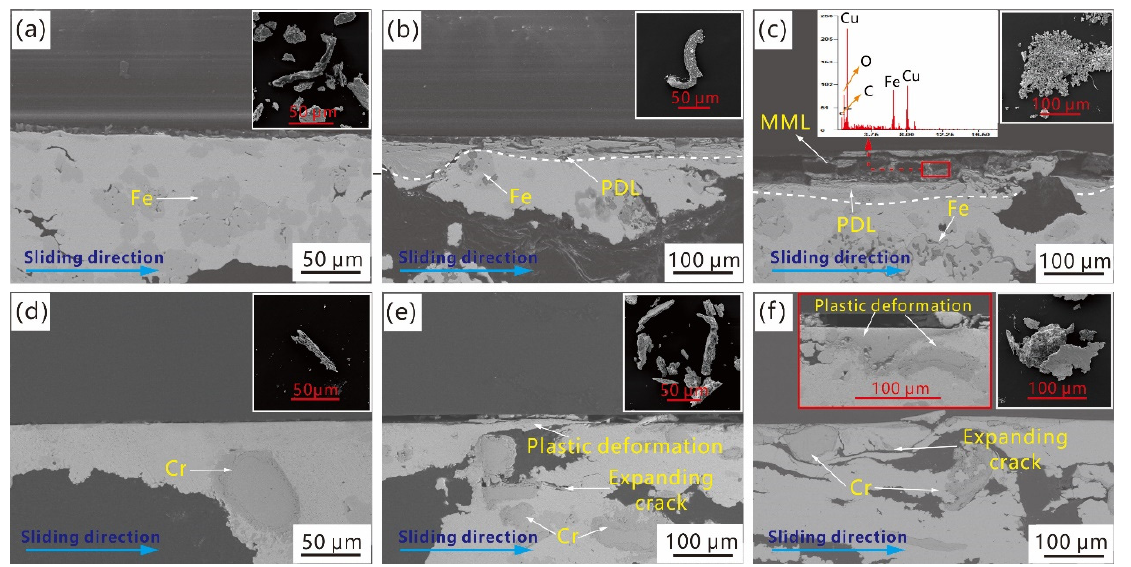
Figure 13. Subsurface and wear debris of Cu–BCs containing Fe and Cr tested under different BEPUA conditions: ( a ) Fe low-BEPUA; ( b ) Fe medium-BEPUA; ( c ) Fe high-BEPUA; ( d ) Cr low-BEPUA; ( e ) Cr medium-BEPUA; ( f ) Cr high-BEPUA.